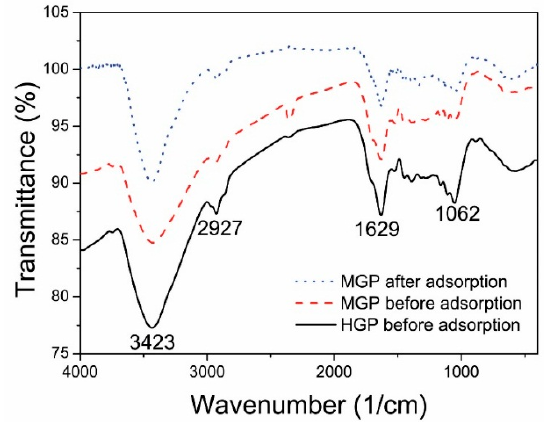
Figure 2. FTIR spectra of HGP before MB adsorption and MGP before and after MB adsorption.